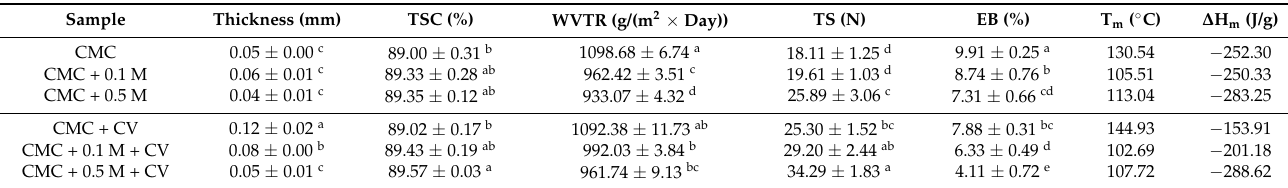
Table 2. Thickness, total solids content (TSC), water vapour transmission ratio (WVTR), tensile strength (TS), elongation at break (EB), melting temperature (T m ), and melting enthalpy ( ∆ H m ) of CMC-based films.